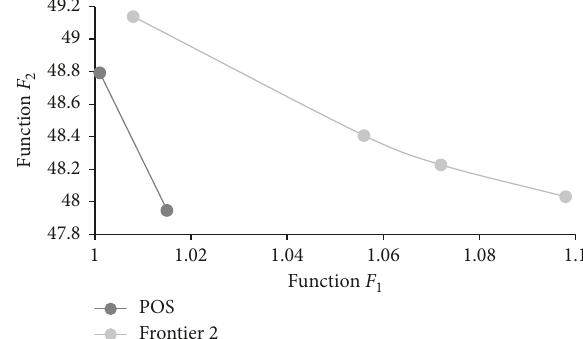
Figure 9: Objective functions F model RC-3.